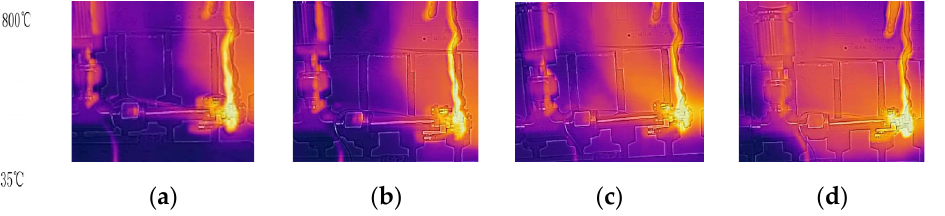
Figure 8. Infrared images of the capillary under different downstream temperatures: ( a ) 623 K ( b ) 723 K ( c ) 823 K ( d ) 923 K.